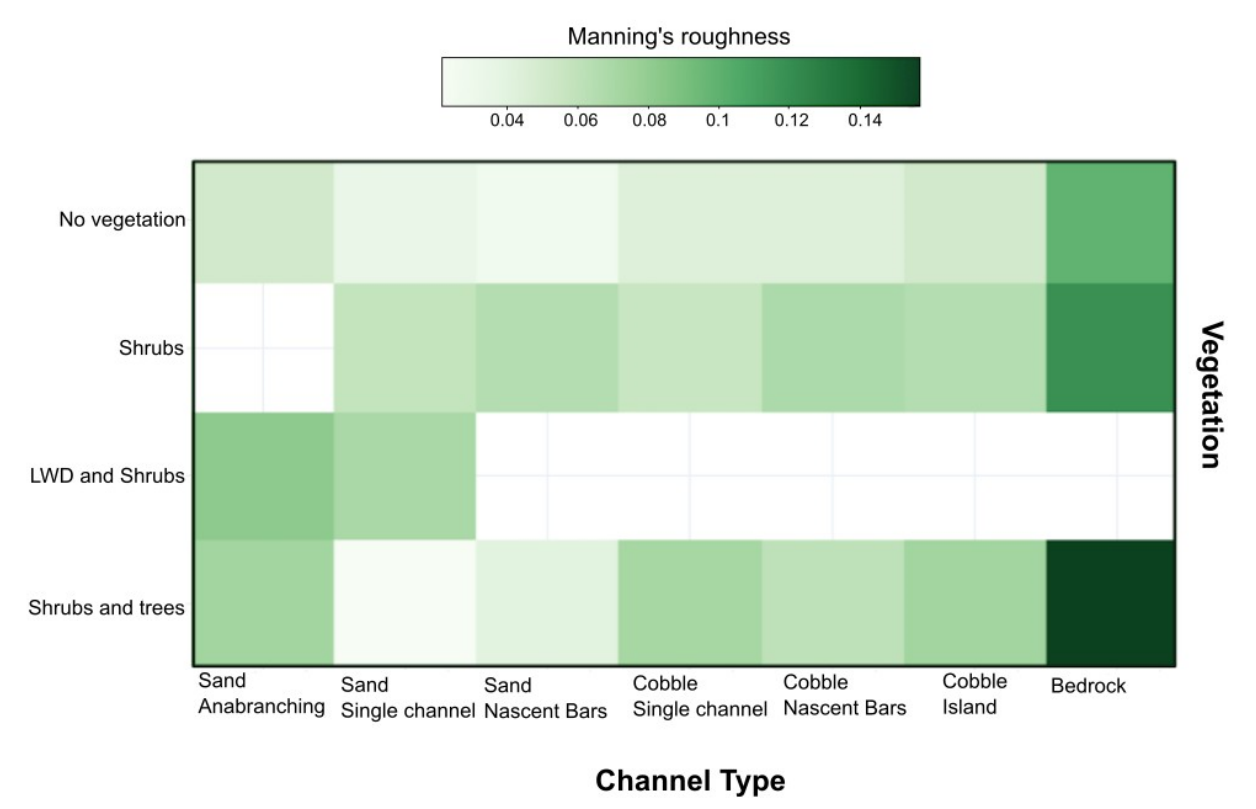
Figure 8. Heatmap to show the relative contribution of different vegetation classes to each of the seven channel types. Darker green indicates that a greater proportion of total roughness is derived from the respective vegetation type, lighter green indicates a smaller proportion of total roughness is derived from the respective vegetation class. White indicates no value, where the channel type and associated vegetation pattern was not observed.